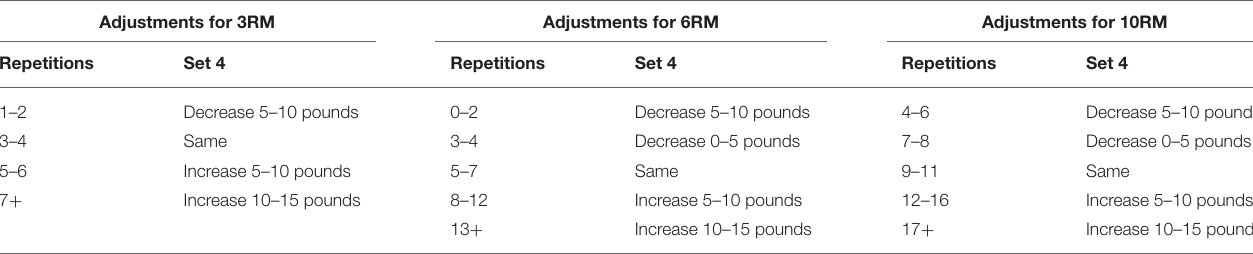
TABLE 3 | Example adjustments for APRE